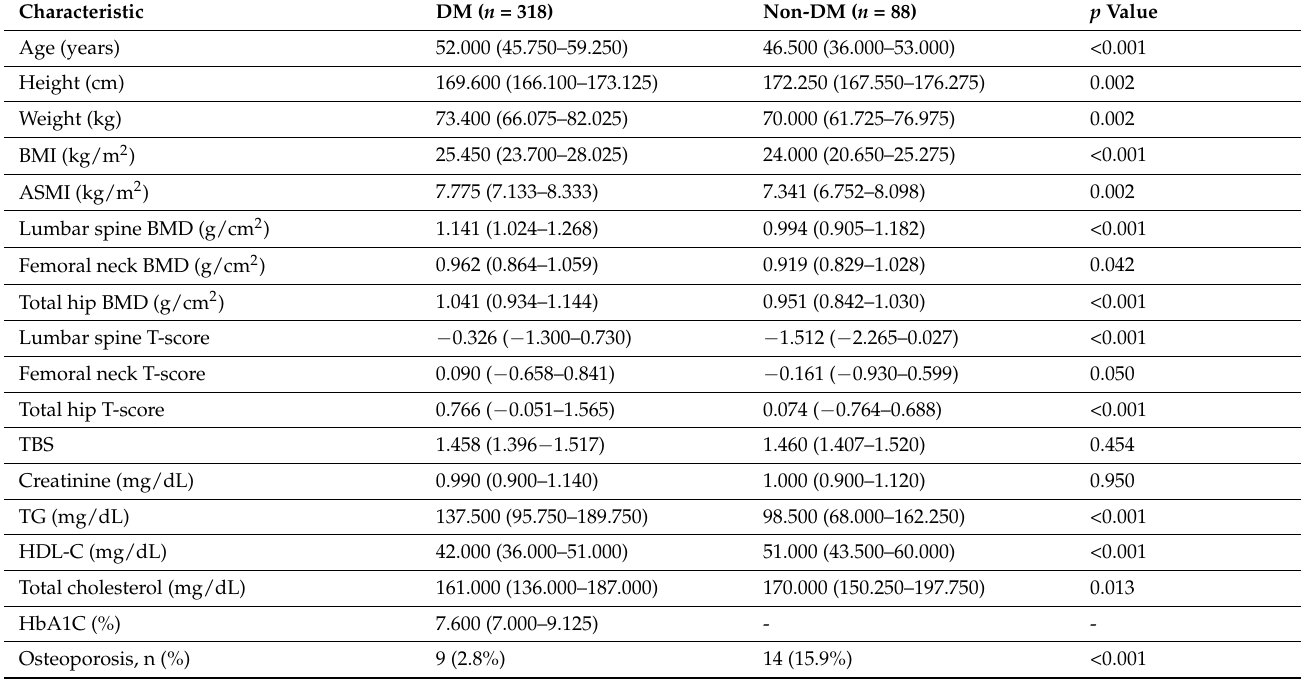
Table 1. Descriptive characteristics of men with diabetes or non-diabetes included in the study.